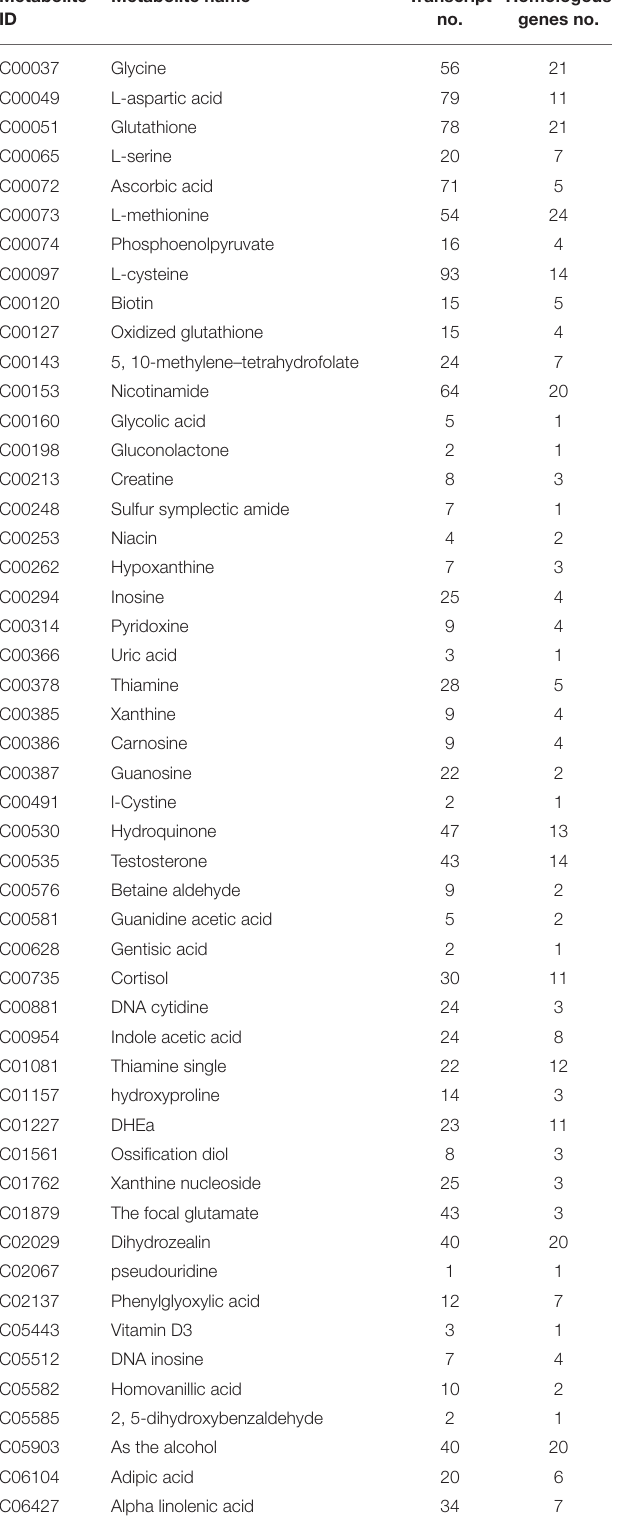
TABLE 4 | Joint analysis results of ovarian metabolites and transcripts in Zi-geese. Metabolite ID